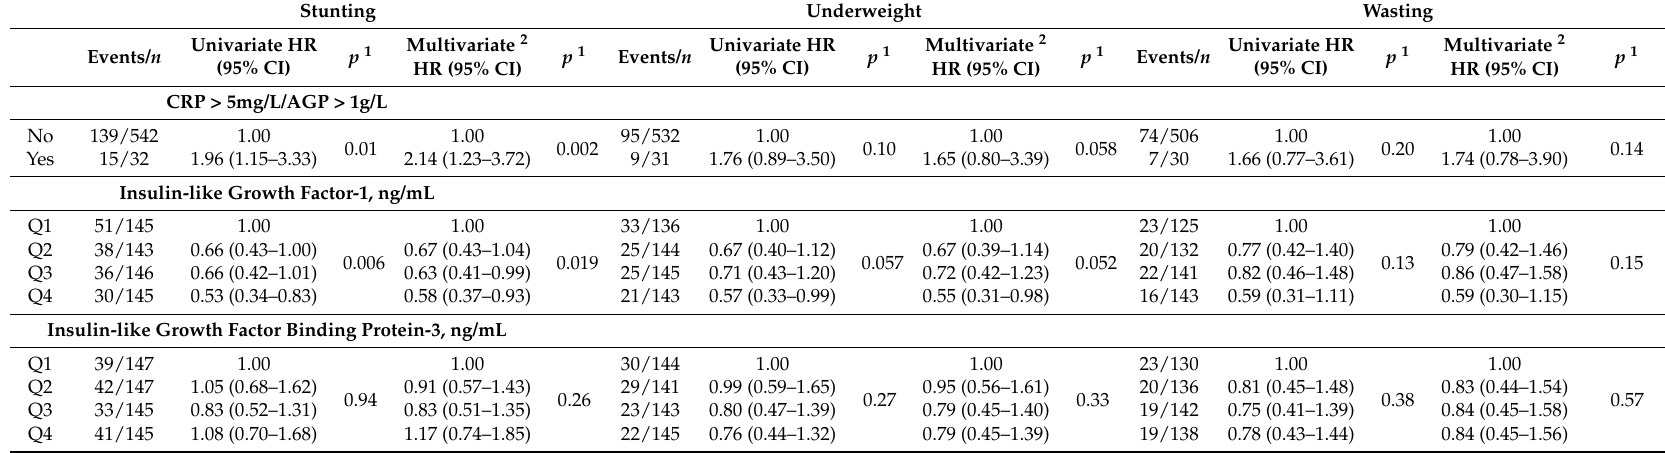
Table 3. Association of inflammatory (CRP, AGP) and growth (IGF-1, IGFBP-3) biomarkers at 6 weeks with subsequent stunting, wasting, and underweight. Stunting Underweight